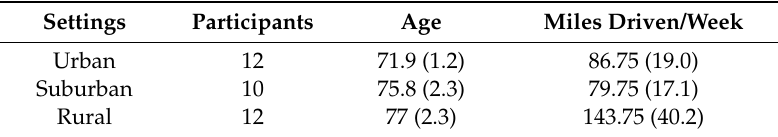
Table 1. Demographic data of older drivers by location.